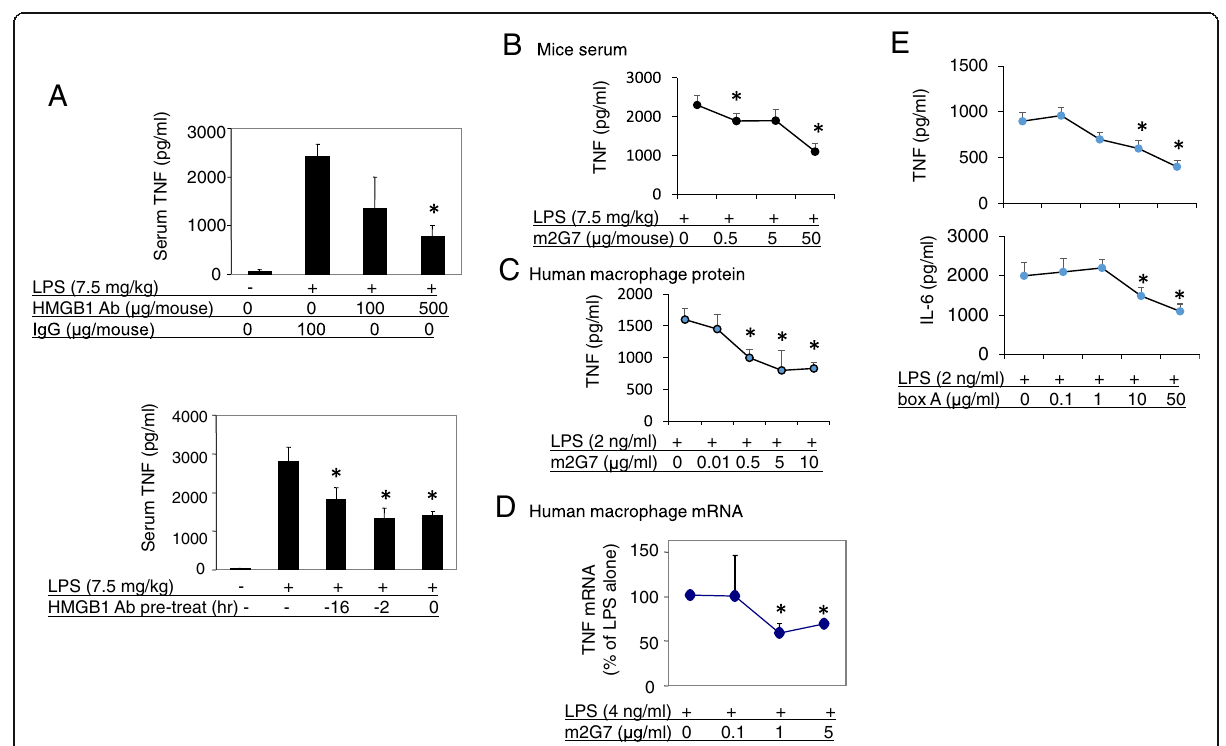
Fig. 1 Anti-HMGB1 antibodies attenuated LPS-induced TNF release in vitro and in vivo . a . Upper: Male BALB/c mice received IP injection of polyclonal rabbit anti-HMGB1 antibody or rabbit control IgG as indicated at time point − 16h, LPS (7.5mg/kg) at 0h (IP injection). Mice were euthanized 2h post LPS administration, and serum TNF was assayed. N =6 – 8 mice per group. *: P <0.05 vs. IgG group. Lower: Male BALB/c mice received IP injection (500 μ g/mouse) of polyclonal rabbit anti-HMGB1 antibody at indicated time points, and were challenged with LPS (7.5mg/kg, IP injection). Mice were euthanized 2h post LPS injection, serum TNF levels were measured by ELISA. N =5 – 10 per group. *: P <0.05 vs. LPS alone. b . Male BALB/c mice had IP injection of m2G7 and LPS and were euthanized 2h later. Serum TNF was measured. N =10 mice per group. *: P <0.05 vs. LPS alone. c . Primary human macrophages were seeded at a density of 10 5 cells/well in 24-well culture plates and were stimulated with LPS (2ng/ml) in the presence or absence of m2G7 for 16h in serum-free Opti-MEM medium. TNF released in the supernatant was measured. N =3 – 4 separate experiments each from different donors. *: P <0.05 vs. LPS alone. d . Primary human macrophages were plated in 60mm plates (10 6 cells/well) and stimulated with LPS in the presence or absence of m2G7 for 60min. Total RNA was isolated, TNF gene expression was examined and expressed as fold change from the GAPDH level. N =4 – 5 experiments each from different donors. Data are expressed as percent of LPS stimulation alone. *: P <0.05 vs. LPS alone. e . Primary human macrophages in 96-well plate (5×10 4 cells/well) were activated with LPS in the presence or absence of box A for 2h at 37°C. TNF (upper) and IL-6 (lower) released were measured. N=4 separate experiments each from different donors. *: P <0.05 vs. LPS